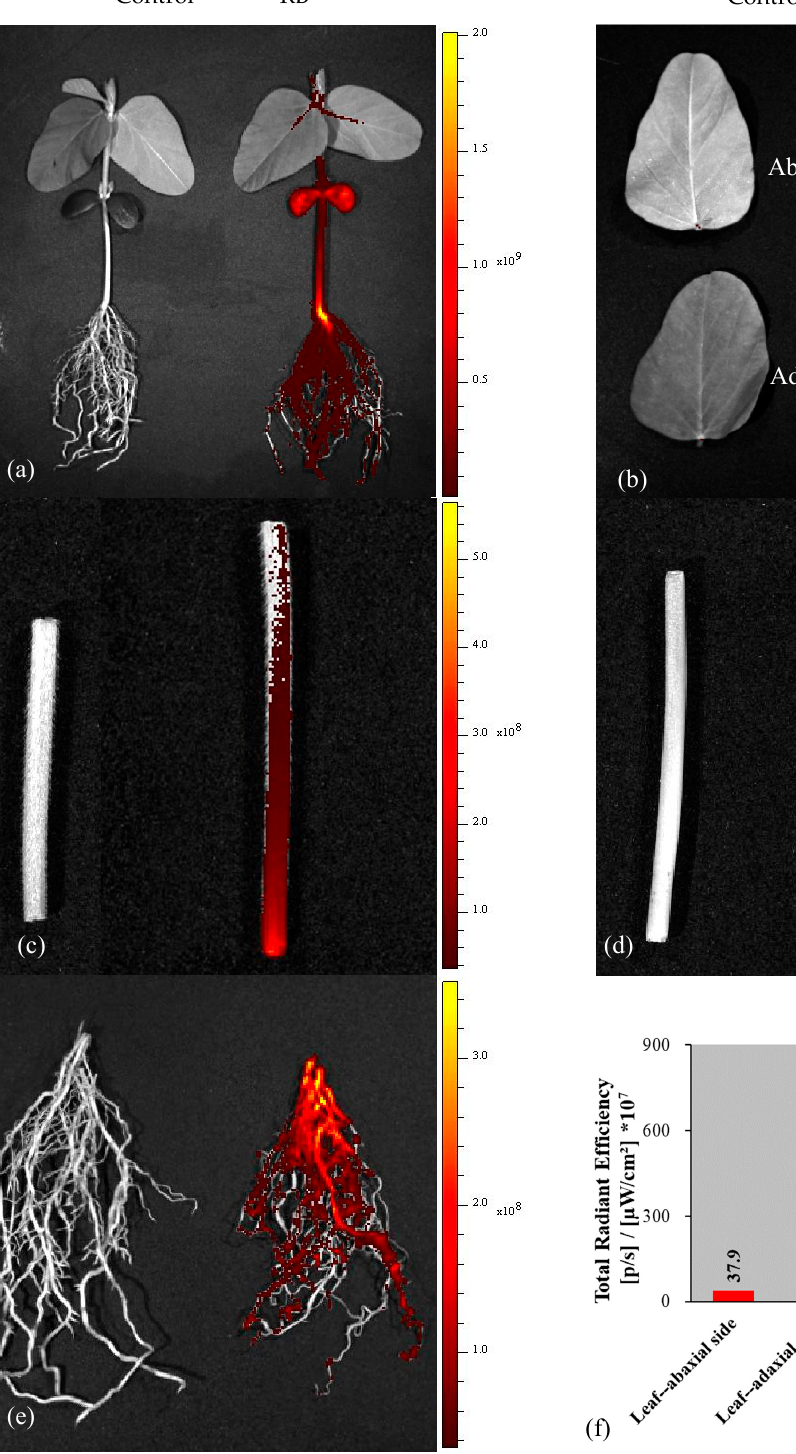
Figure 4. Imaging of rhodamine B (RB) uptake in soybean seedlings under the in vivo imaging system (IVIS): ( a ) whole plant, ( b ) leaf, ( c ) epicotyl, ( d ) hypocotyl, ( e ) root, and ( f ) fluorescence intensity in di ff erent parts of soybean